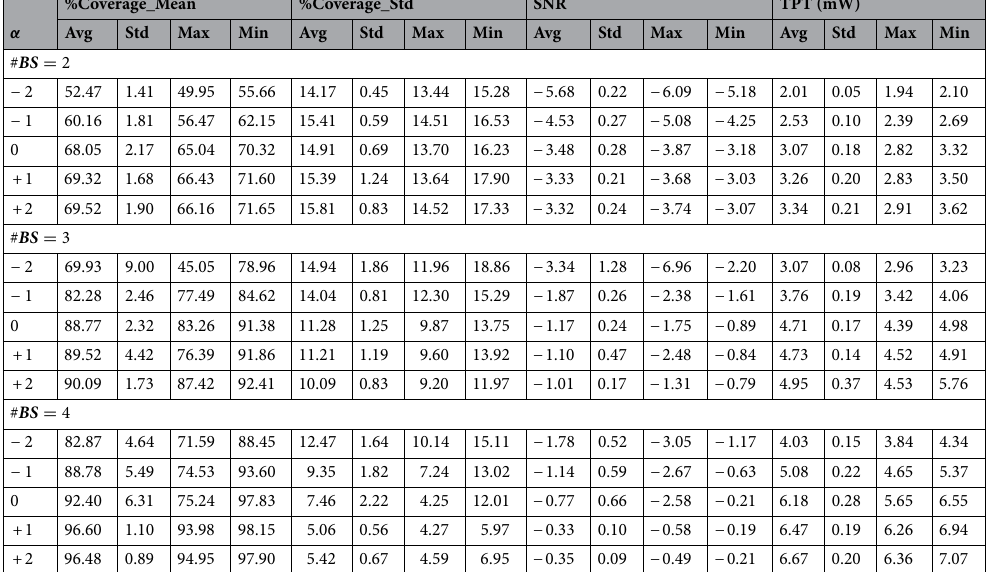
Table 2. Statistical results over 10 repetitions of proposed Kriging-GWO (hybrid surrogate-metaheuristic) approach in robust optimal placement of two, three, and four transmitting antennas for different " α " values in Eq. (19).